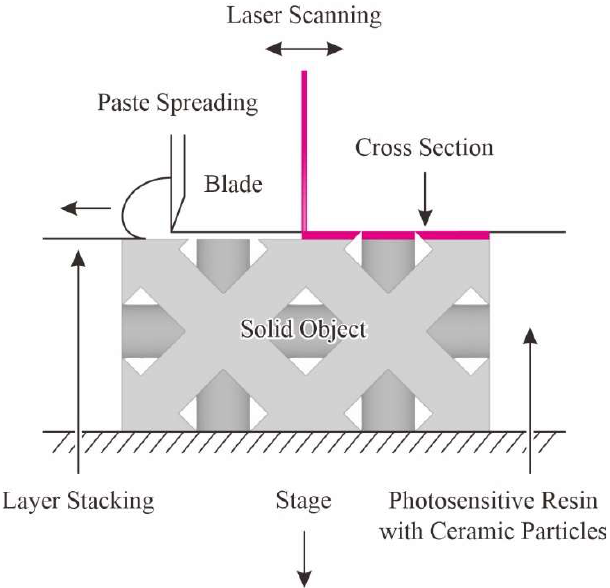
Figure 4. A schematic illustration of process sequences in stereolithographic additive manufacturing (STL-AM). An ultraviolet (UV) laser beam was scanned on spread resin pastes with fine particles, to draw cross-sections. A solid component was automatically formed through layer lamination and interlayer bonding.